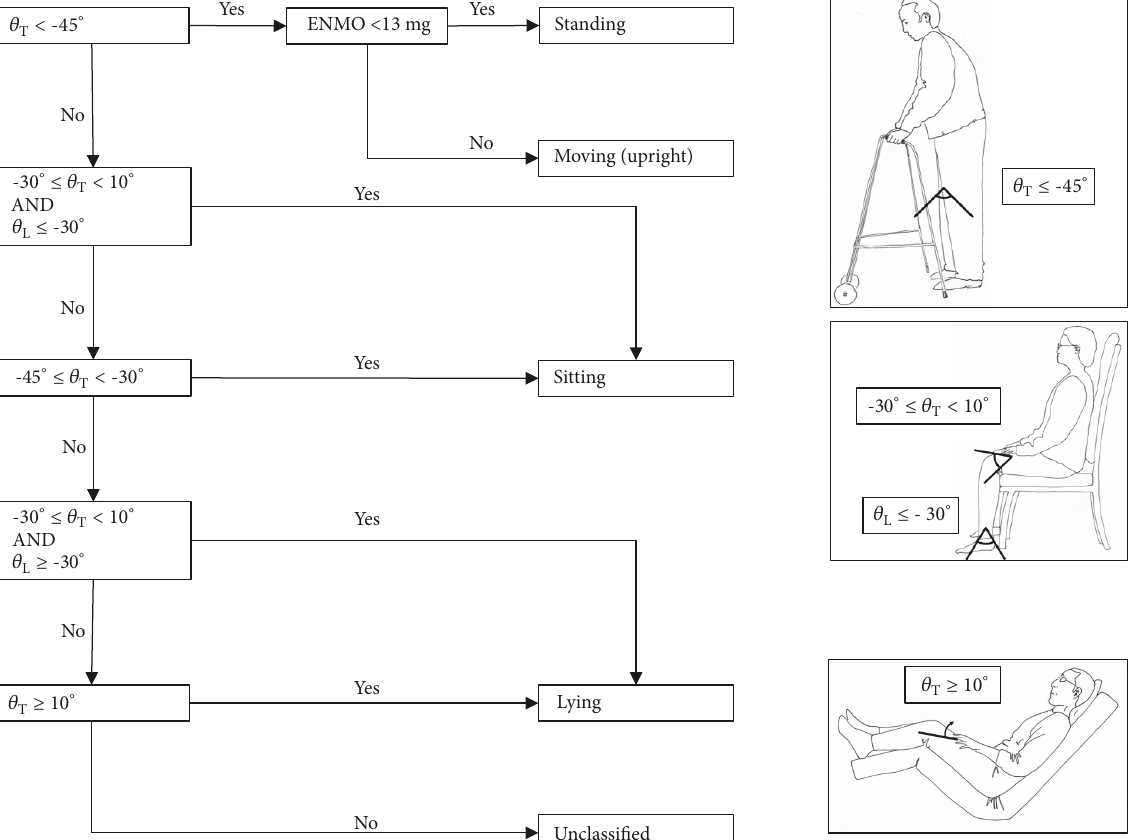
Figure 2: Algorithm for determining participant posture and movement ( 𝜃 T = pitch angle of thigh accelerometer, 𝜃 L = pitch angle of lower leg accelerometer, and ENMO from lower leg accelerometer).